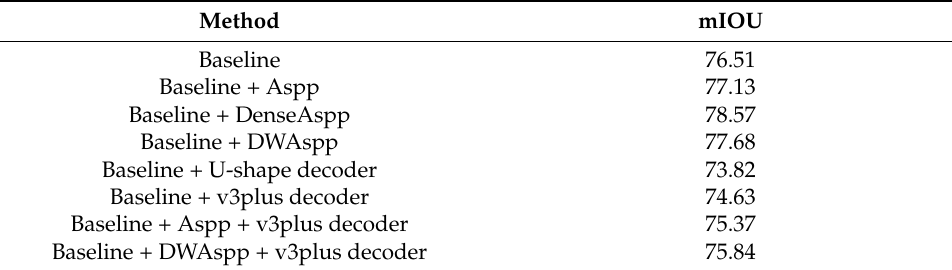
Table 3. Detailed Performance of Our Method with Different Settings.